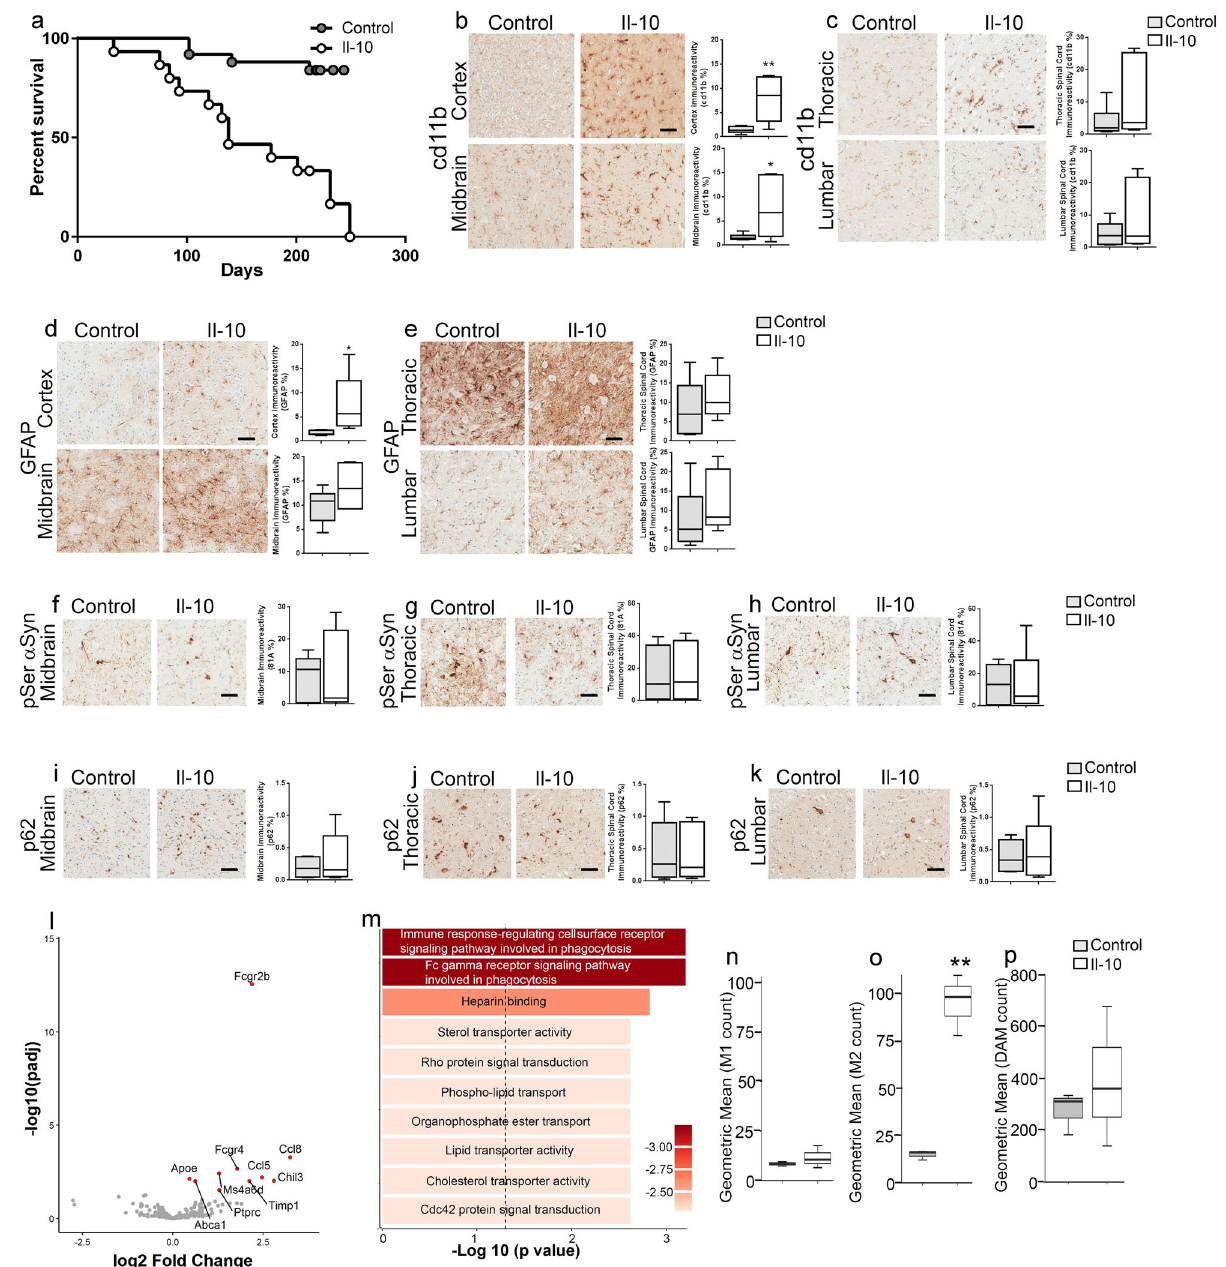
Fig. 1 Intraspinal Il-10 expression accelerates death in homozygous M83 mice. a Intraspinal expression of AAV-Il-10 leads to early mortality in M83 + / + mice. The median age of survival of Il-10-expressing mice was 138 days, and the median age for the AAV-GFP-expressing mice was unde fi ned (log-rank test, P < 0.0001, n = 15 – 16 mice/group). b , c Microgliosis (cd11b staining) in the brain ( b , cortex and midbrain) and spinal cord ( c , thoracic and lumbar segment) of M83 + / + mice. d , e Astrocytosis (GFAP staining) in the brain ( d , cortex and midbrain) and spinal cord ( e , thoracic and lumbar segment) of M83 + / + mice. f – k Representative images from anti-81A ( f – h ) and anti-p62 ( i – k ) antibody-stained tissue. Immunostaining analysis is shown from the midbrain ( f , i ), the thoracic segment of the spinal cord ( g , j ), and the lumbar segment of the spinal cord ( h , k ). Scale bar: 50 µm. n = 6 mice/group; two-tailed t test. l – p Volcano plot ( l ) showing differential expression of genes in the thoracic spinal cords of Il-10-expressing M83 + / + mice compared to GFP-expressing controls. Red dots, signi fi cantly changed genes, P < 0.05; gray dots, P > 0.05. To avoid skewing the graph, the x axis is limited to a range of − 3 to + 3 and as a result, Il-10 data is not shown (log2 FC = 13.49; P adj value = 1.64 × 10 − 51 ). Gene ontology analysis of overrepresented categories using a list of signi fi cantly changed genes from panel l ( P adj < 0.05; dotted line) ( m ). n = 3 mice/group. FDR < 0.05. P adj = P values adjusted for multiple comparisons. n – p M1, M2-, and DAM-phenotype pro fi le of microglia in Il-10-expressing M83 + / + mice compared to GFP-expressing M83 + / + control mice. ** P < 0.01. n = 3 mice/group. In the box plot, the whiskers extend from the minimum to maximum values, with the midline representing the